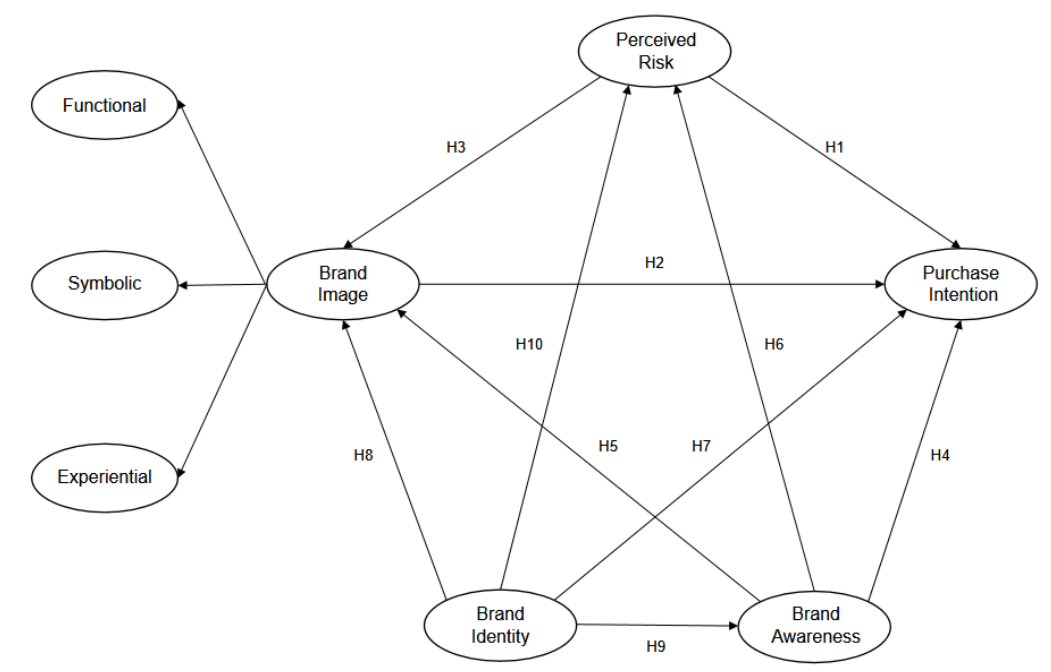
Figure 1. Research structure. Table 1. Measurement